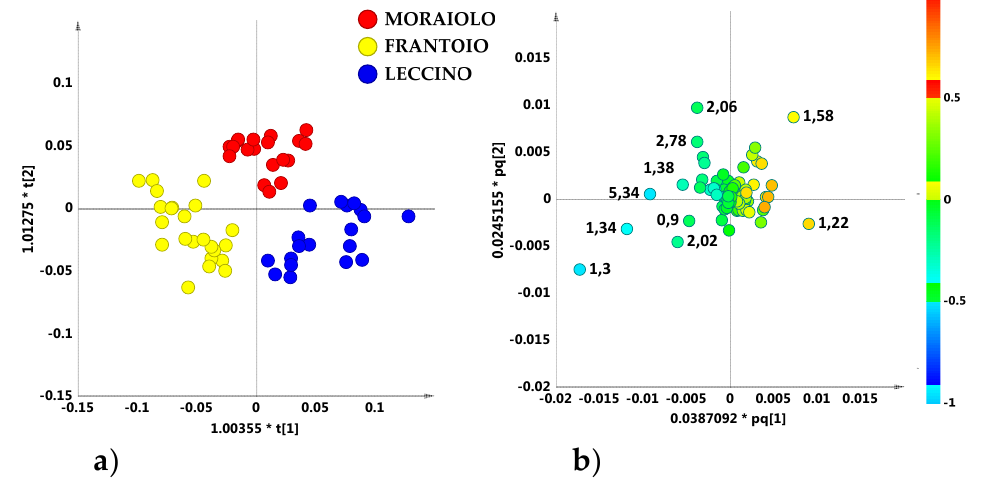
Figure 5. ( a ) OPLS ‐ DA (2 + 4 + 0 components give R 2 X = 0.83, R 2 Y = 0.74, Q 2 = 0.57) scores plot for main cultivar micro ‐ milled olive oil samples from the observed compact macro group. ( b ) Loading scatter plot for the model indicating the molecular component responsible for the cultivar separation. NMR spectra with detailed assignment of discriminating metabolites are reported as Figure S1 in SI.